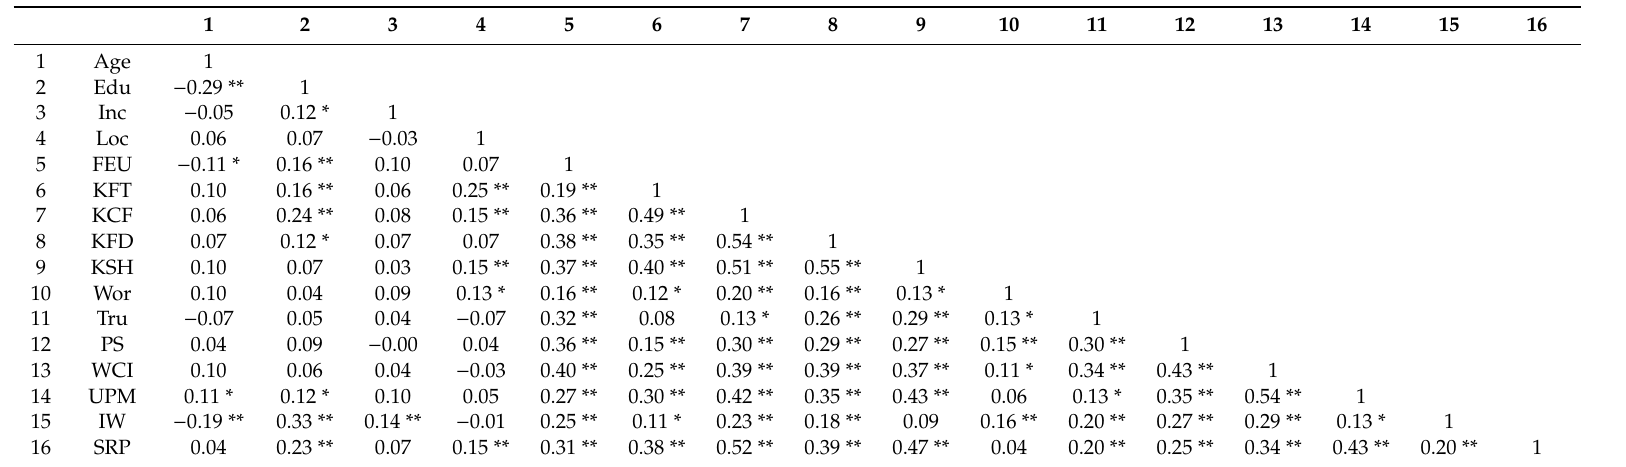
Table 3. Correlation matrix of the relations between flood risk perception, socio-demographic factors, flood risk knowledge, flood risk attitudes, and protective coping